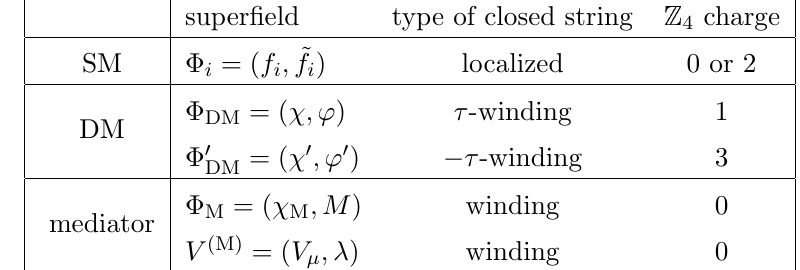
Table 1. Summary of the relevant (cid:12)elds for SM, DM and mediator and their corresponding types of strings (i.e. localized strings, (cid:28) -winding strings or general winding strings). (cid:8) 0 mass partner of the dark matter multiplet (cid:8) DM